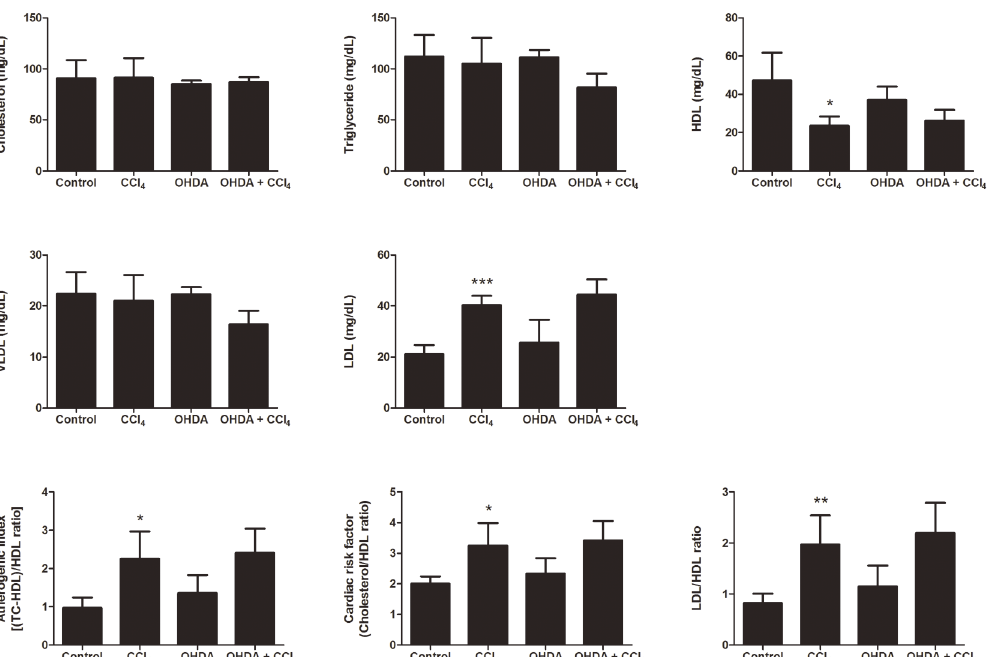
Fig 5. Effect of ablation of the sympathetic nervous system on serum lipid profile in mice. (A) Serum total cholesterol, triglyceride, high-density lipoprotein (HDL), very low-density lipoprotein (VLDL), and low-density lipoprotein (LDL) in mice administered sympathetic denervation for 5 d following CCl 4 intoxication. (B) Serum atherogenic index, cardiac risk factor, and LDL/HDL ratio in mice with sympathetic denervation following CCl 4 intoxication. Bars are means ± SD, n = 6 mice per group. In all figures, significant differences are noted as * p < 0.05 vs. control, ** p < 0.01 vs. control, and *** p < 0.001 vs. control.